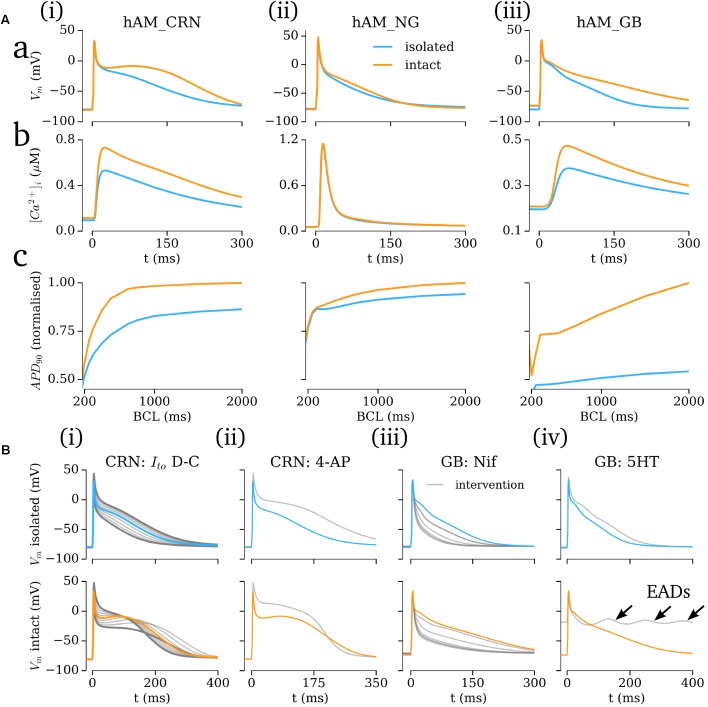
Isolated- vs intact-cell properties. (A) Action potentials (a), calcium transient (b), and APD restitution (c) plotted against basic cycle length (BCL), for the three baseline cell model (i–iii) variants for isolated (blue) and intact (orange). The APD curves were normalized to the intact-cell APD at a cycle length of 2000 ms. (B) Comparison of isolated (upper) and intact (lower) cell model response to various interventions (gray). Arrows in (iv) lower panel indicate early-after-depolarizations (EADs).